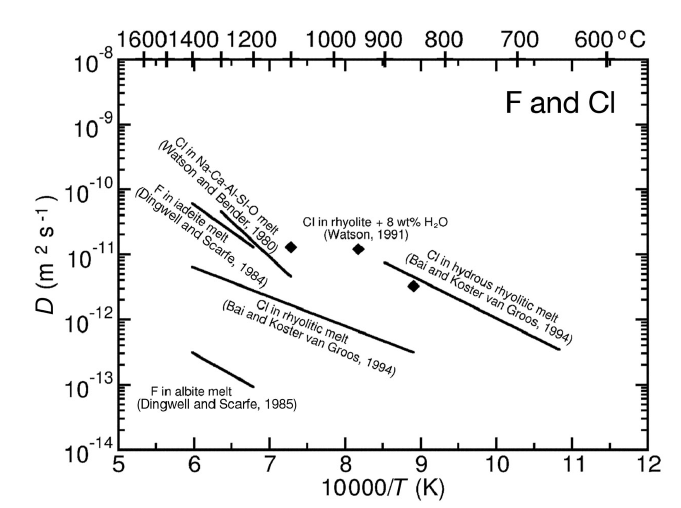
Fig. 5. Diffusion of halogens in magmatic silicate